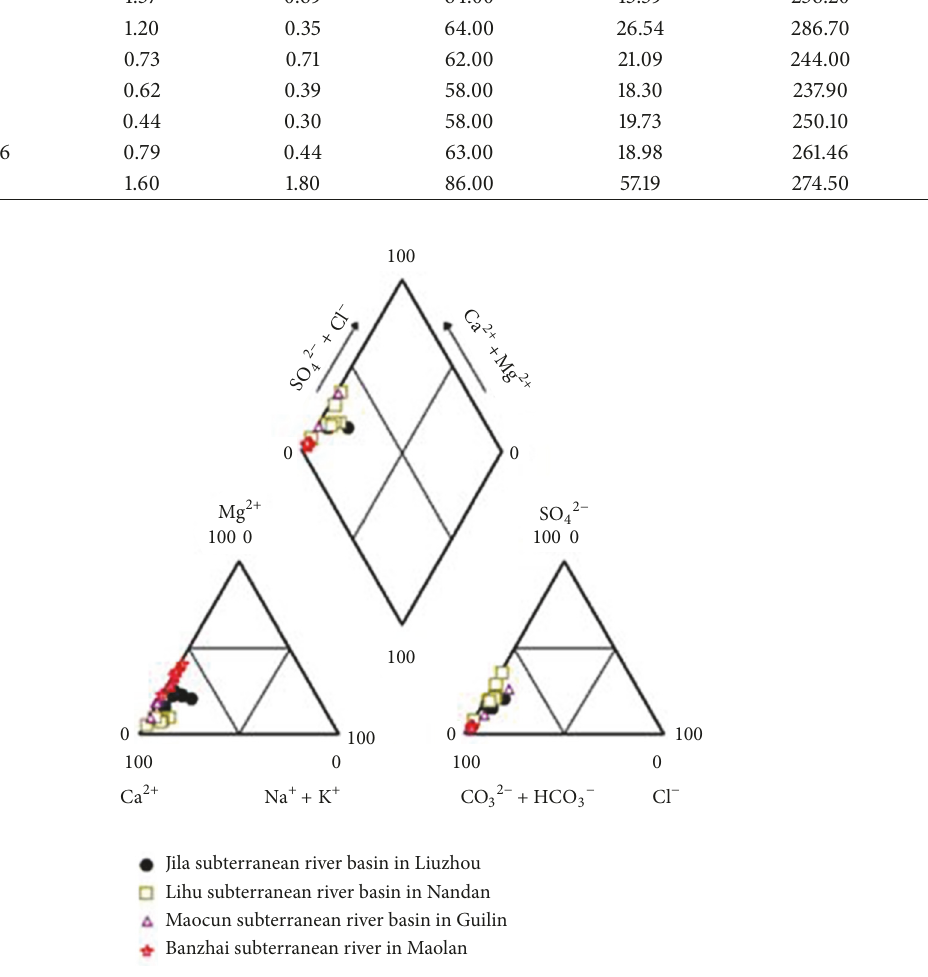
Figure 6: Hydrogeological types in the four subterranean river